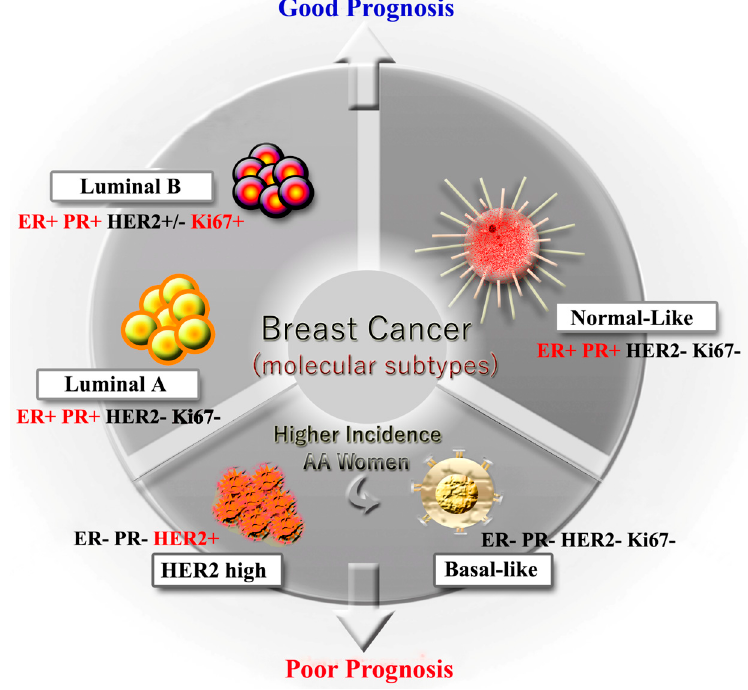
Figure 1. Di ff erent molecular subtypes of breast Figure 1. Different molecular subtypes of breast cancer.